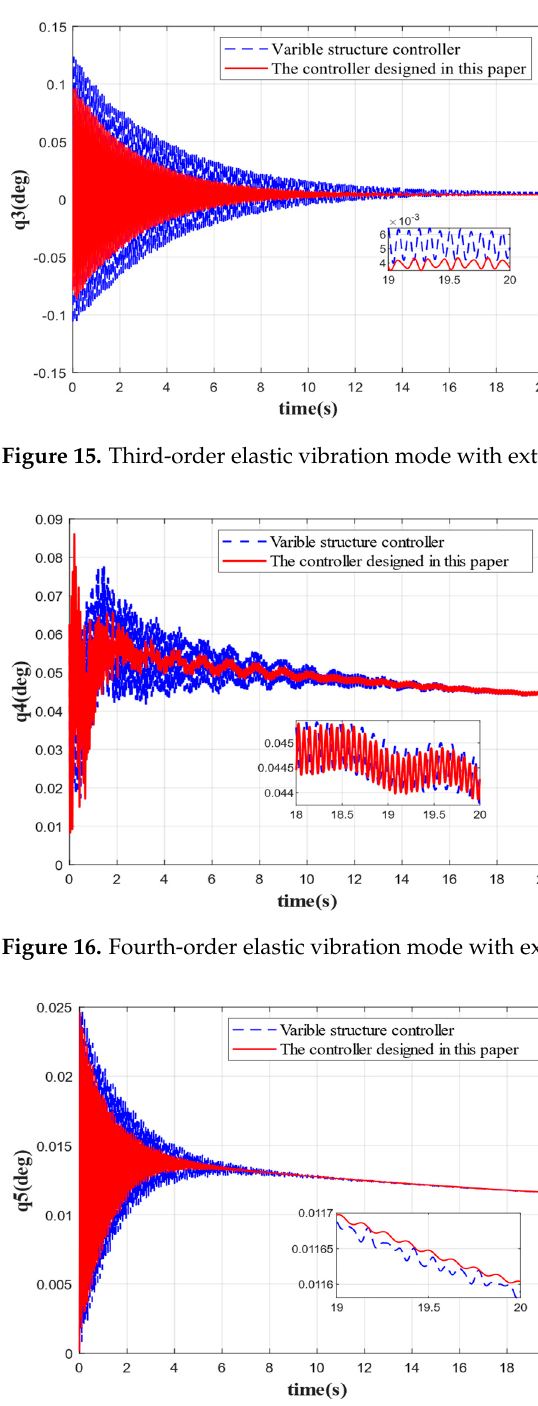
Figure 18. Angle of rudder reflection with external interference. Figures 11 and 12 show the reconstruction of the attitude angle and angular velocity by the variable ‐ gain robust observer designed in this paper when external interference is taken into account. When external interference is ignored, the observer converts the perturbation effect of elastic vibration on the attitude angle into an additional attitude angle, which makes the reconstructed curve much smoother than before reconstruction. Moreover, it can be seen from Figure 12 that the filtering effect of the angular velocity is significantly im ‐